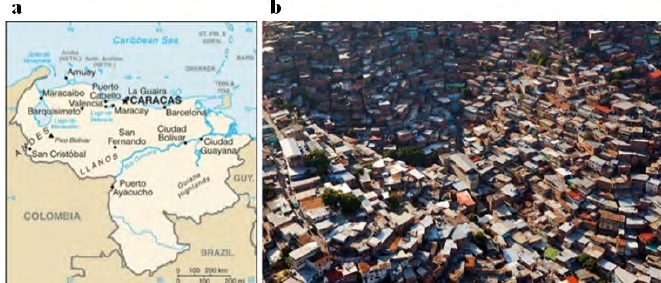
Figure 6. (a) Caracas Map. (b) The dense urbanization of Chacao, Caracas. Source: Aerial view of slums in Caracas, Venezuela. Source Urban-Think Tank,